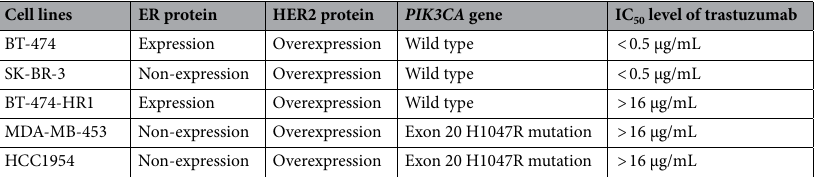
Table 1. Characteristics of the five breast cancer cell lines. ER, estrogen receptor; HER2, human epidermal growth factor receptor 2.